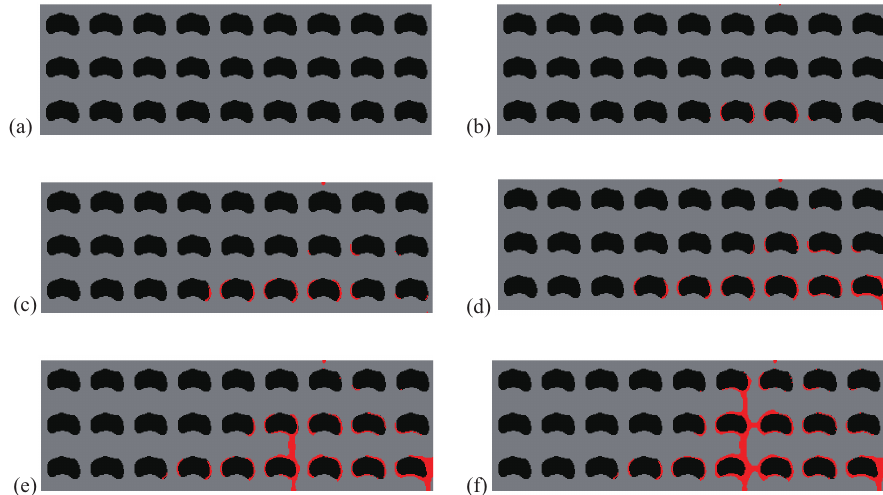
Figure 12. Crack propagation in the periodic composite subjected to non-symmetric three-point bending, optimized design: ( a ) ¯ U = 0 mm; ( b ) ¯ U = 0.17 mm; ( c ) ¯ U = 0.24 mm; ( d ) ¯ U = 0.33 mm; ( e ) ¯ U = 0.39 mm; ( f ) ¯ U = 0.44